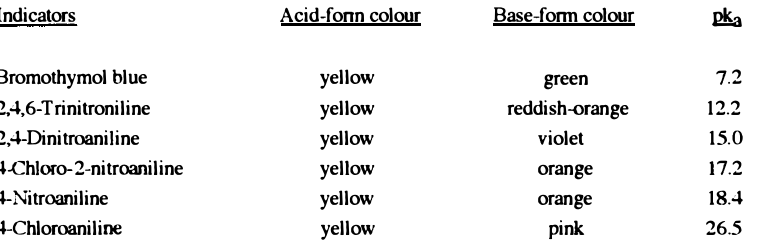
Table 2. Acidic indicators used f orthe measurement of basic strength (afterTanabe